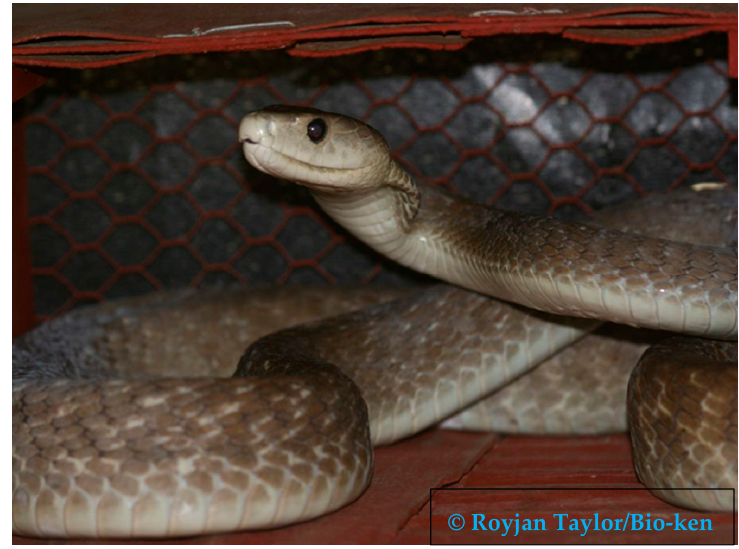
Figure 1 . Black mamba ( Dendroaspis polylepis ). Figure 1. Black mamba ( Dendroaspis polylepis